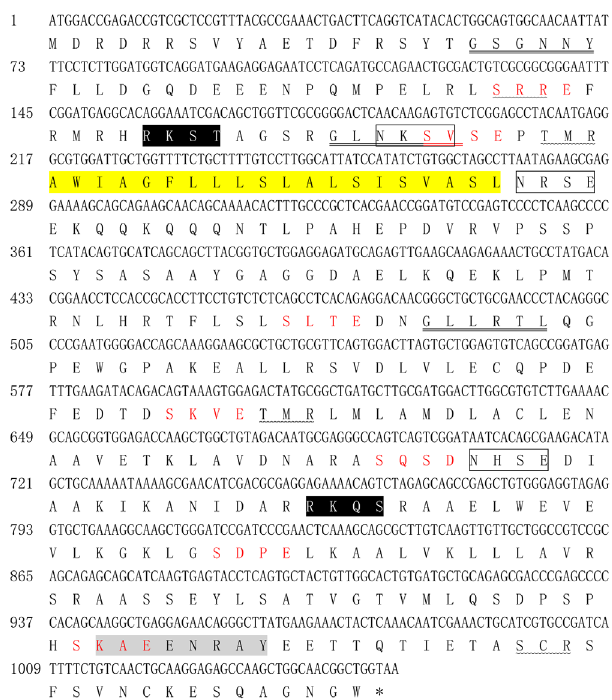
Figure 2. Bioinformatic analysis of Et CHP18905. The stop codon is indicated with an asterisk. N-myristoylation sites are double underlined. The transmembrane domain is shaded yellow with black lettering. N-glycosylation sites are surrounded by a black box. cAMP- and cGMP-dependent protein kinase phosphorylation sites are shaded black with white lettering. Tyrosine kinase phosphory- lation site is shaded grey with black lettering. Casein kinase II phosphorylation sites are indicated with red lettering. Protein kinase C phosphorylation sites are underlined by a wavy